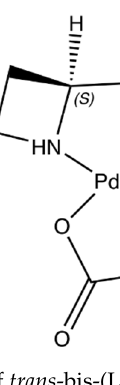
Figure 11. ORTEP plot of cis -bis-(L-pipecolinato)palladium(II), ( 7 ). Thermal ellipsoids are shown at the 50% probability level. CCDC:1913623.